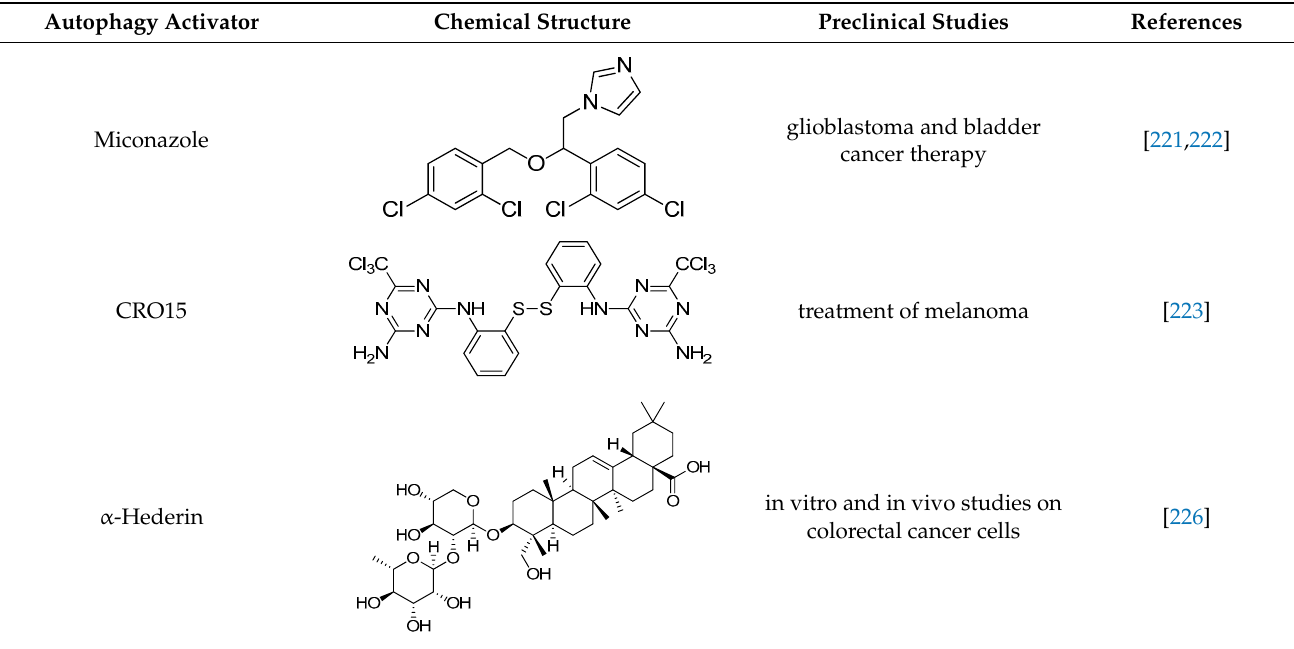
Table 6. Selected autophagy activators under preclinical investigation.